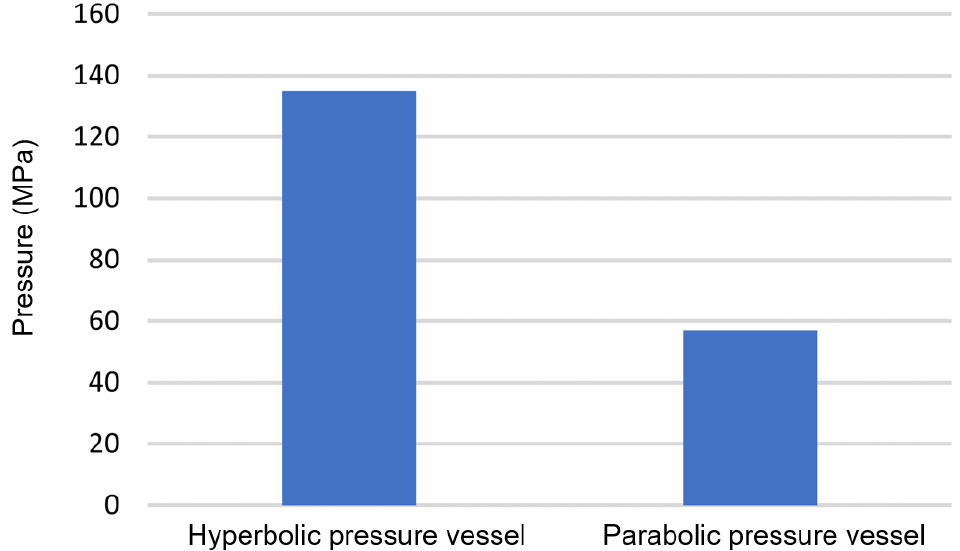
Figure 12. Comparison of the maximum pressure values of the water element in the center of the AZ31 plate due to the differences in pressure vessel shape calculated by numerical simulation.